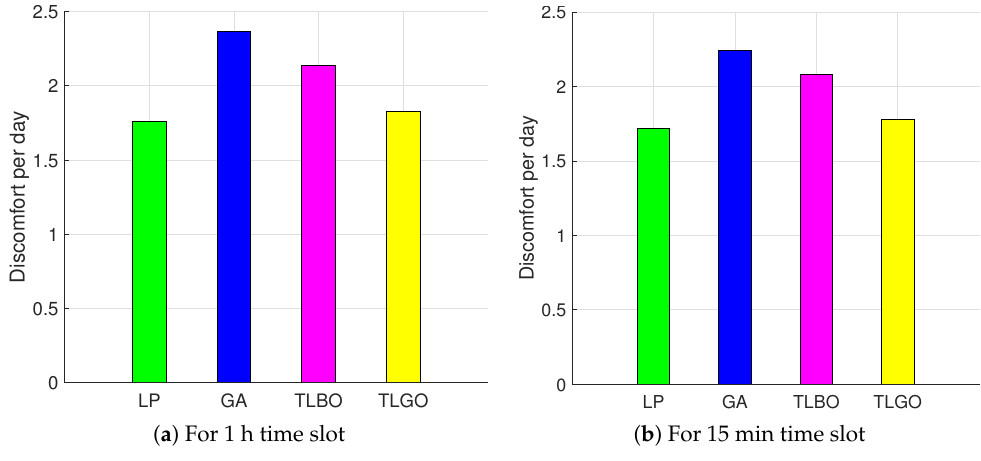
Figure 9. Discomfort under